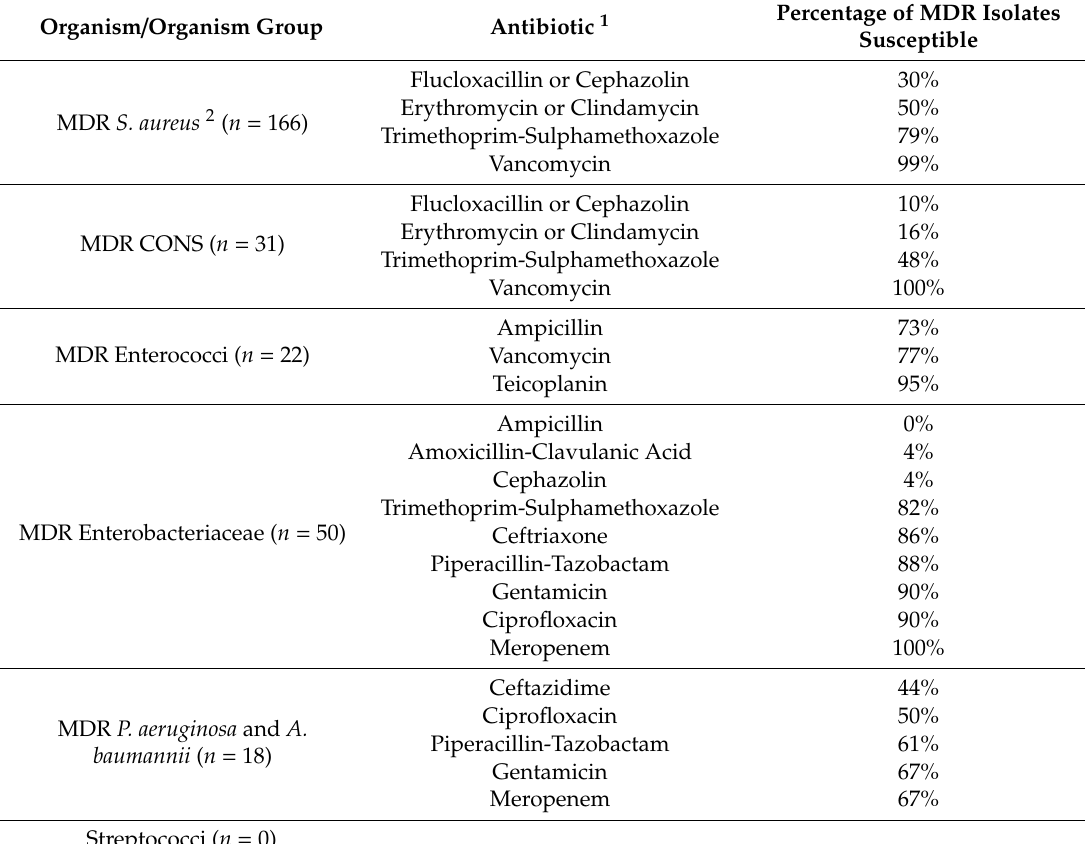
Table 2. Antibiotic susceptibilities of MDR bacteria cultured from patients in the 12 months following orthopaedic lower limb surgery in Australian tropical and subtropical